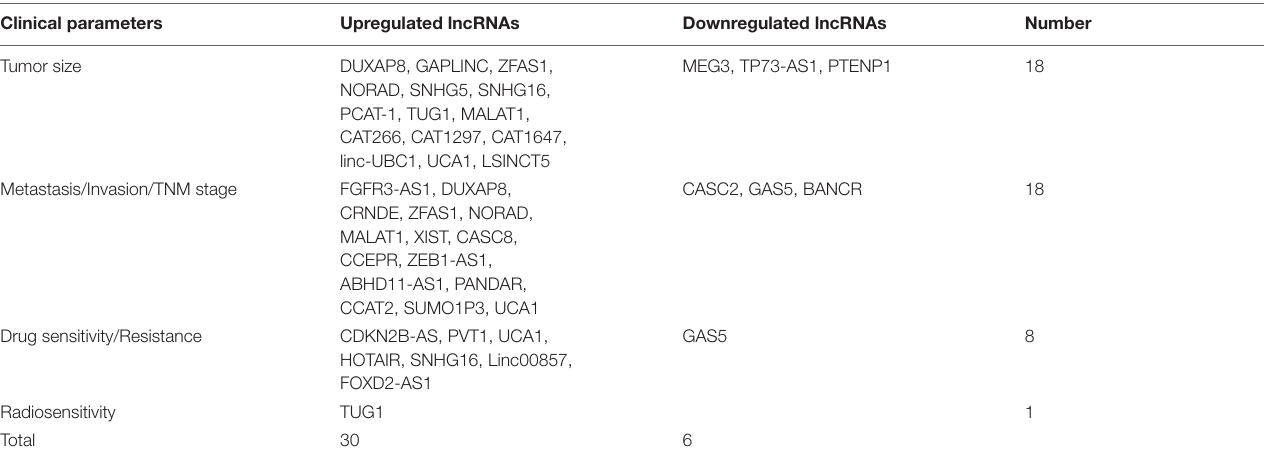
FIGURE 3 | LncRNAs that interact with proteins in BC. (A) UCA1 interacts with C/EBP α . (B) Lnc-LBCS directly binds to hnRNPK and EZH2, and inhibits SOX2 transcription. (C) XIST-TET1-p53 pathway in BC. (D) DGCR5 promotes P21 transcription by interacting with ARID1A. (E) LSINCT5 promotes tumor progression by interacting with NCYM, and inhibiting GSK3 β activity and promoting Wnt/ β -catenin signaling activation. (F) GAS5 inhibits EZH2 transcription by interacting with E2F4. (G) AWPPH promotes cell proliferation, autophagy, and migration through binding to SMAD4 via EZH2. P indicates the promoter. (H) LNMAT1 regulates CCL2 expression through interacting with hnRNPL. TABLE 3 | Correlation of clinical parameters and lncRNAs in